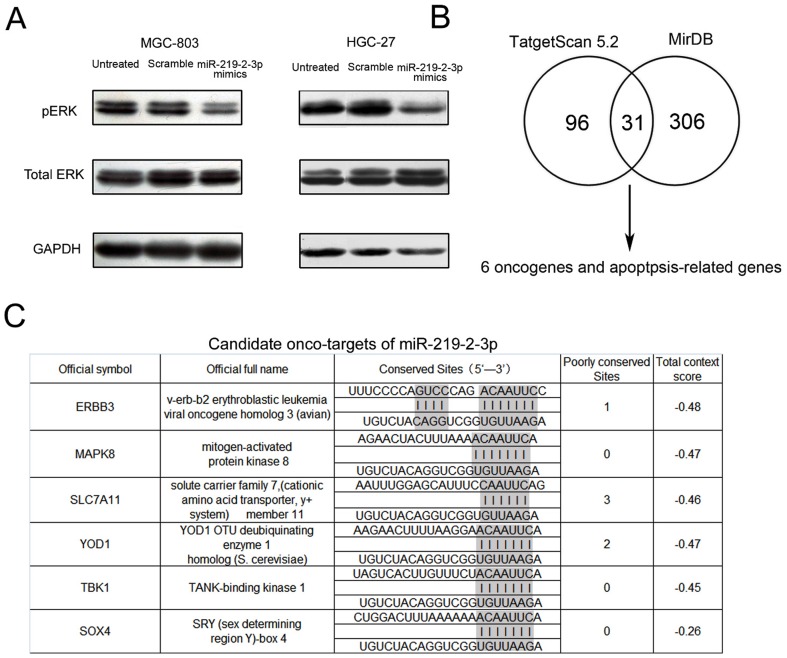
miR-219-2-3p inhibits activation of p-ERK1/2.(A) MGC-803 and HGC-27 cells untreated and transfected with scrambled or miR-219-2-3p mimics were subjected to western blot analysis of phosphorylated ERK1/2, total ERK1/2 and GAPDH (as a loading control). The data shown is representative of three individual western blot analyses. (B) The candidate onco-targets of miR-219-2-3p forecast by TargetScan Release 5.2, and miRDB. (C) Bioinformatically and functionally implicated miR-219-2-3p in GC.